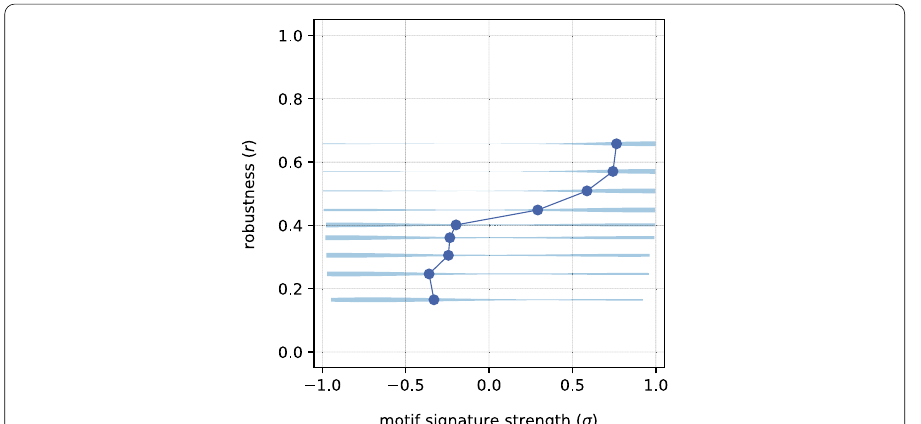
Fig. 8 Distribution of r values as a function of σ for the results of ( c , σ) optimization. Sets of networks that correspond to given robustness are plotted as violin plots to demonstrate their distributions, while the solid line shows the behavior of their